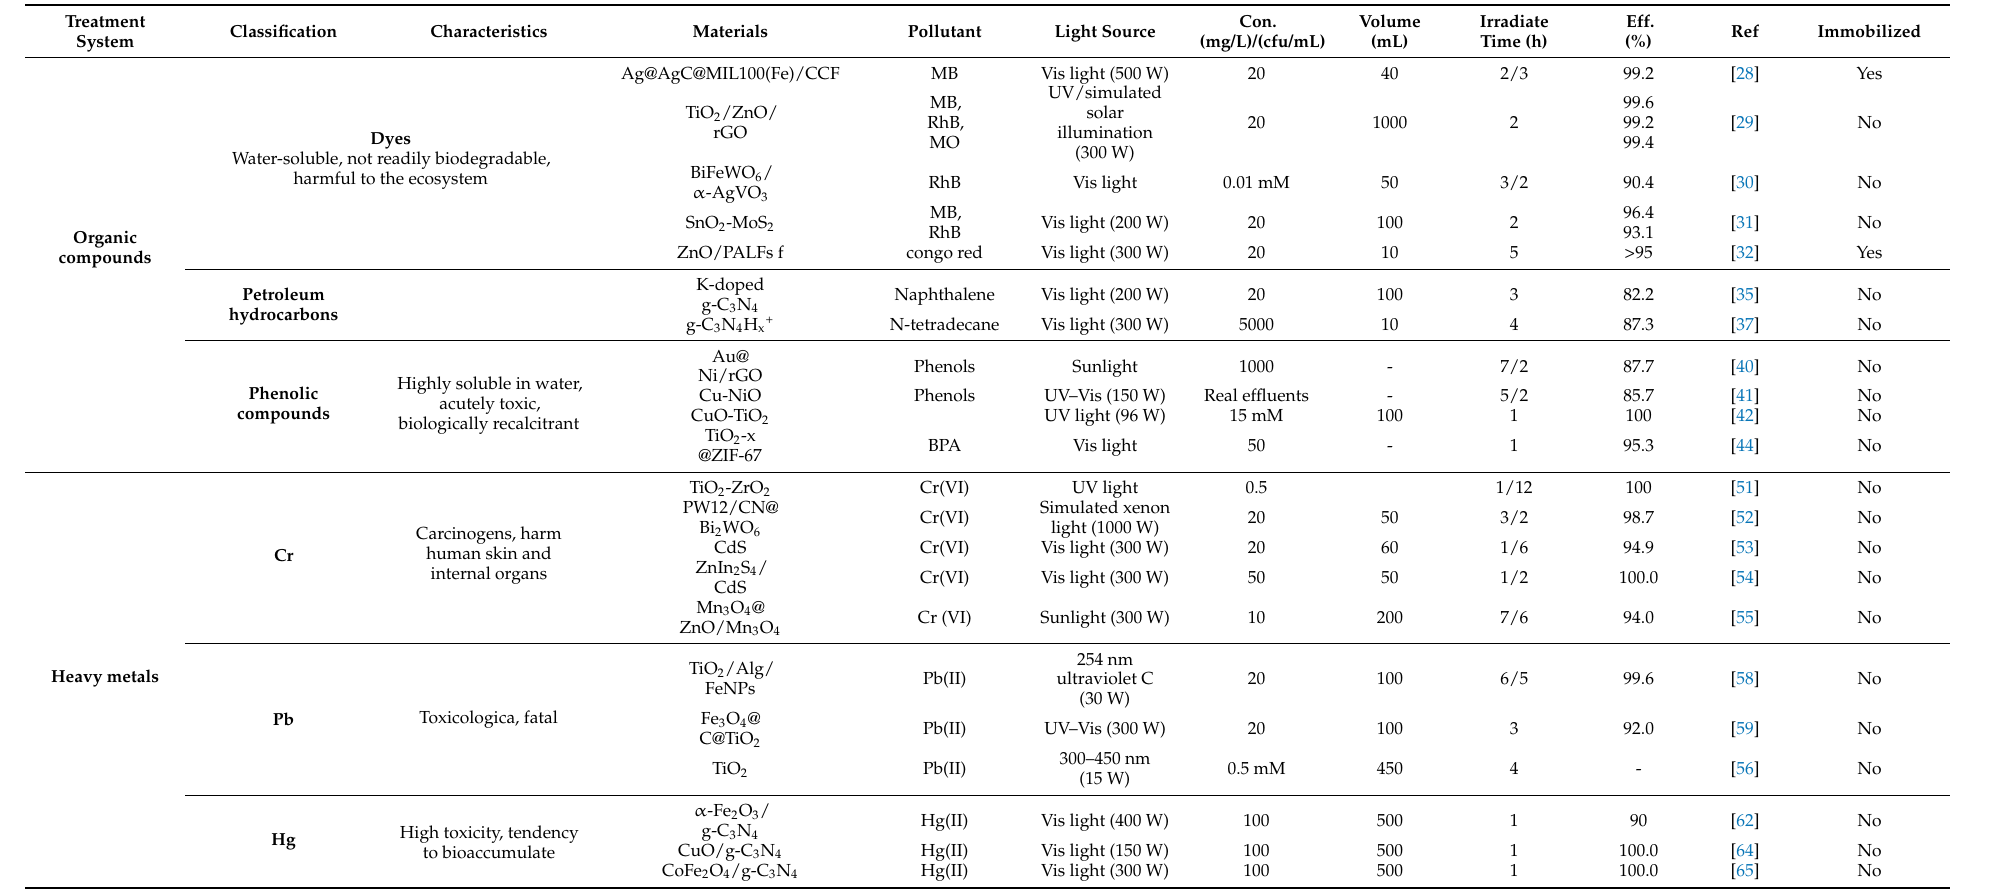
Table 1. Photocatalytic removal of several common categories of water